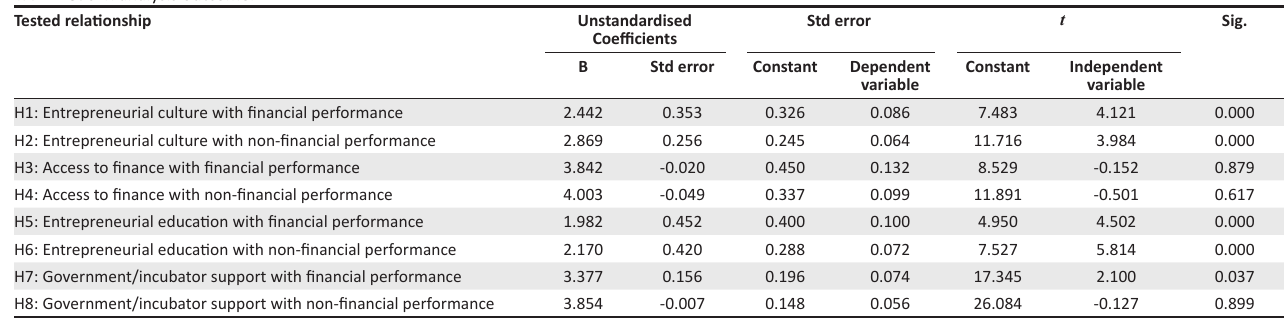
TABLE 3: SLR analysis